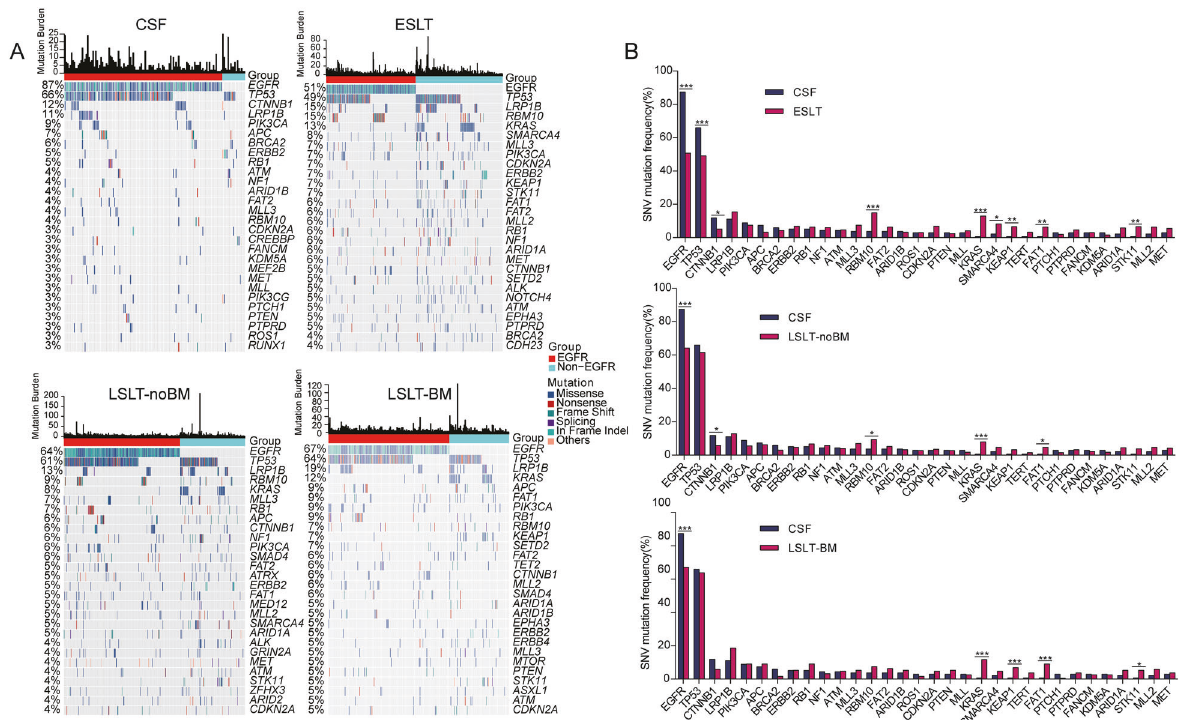
Fig. 2 SNVs analysis of LUAD patients at different stages. A Driver gene mutation pro fi les of the CSF, ESLT, LSLT-noBM, and LSLT-BM groups. Mutation frequencies in the group are shown on the left. Mutation burden (number of mutations per Mb) for each patient is shown at the top. B Comparison of mutation frequencies of driver genes between CSF and the other three groups, respectively. Signi fi cant differences of genes were calculated by two-sided Fisher ’ s exact test. * P < 0.05, ** P < 0.01, *** P <